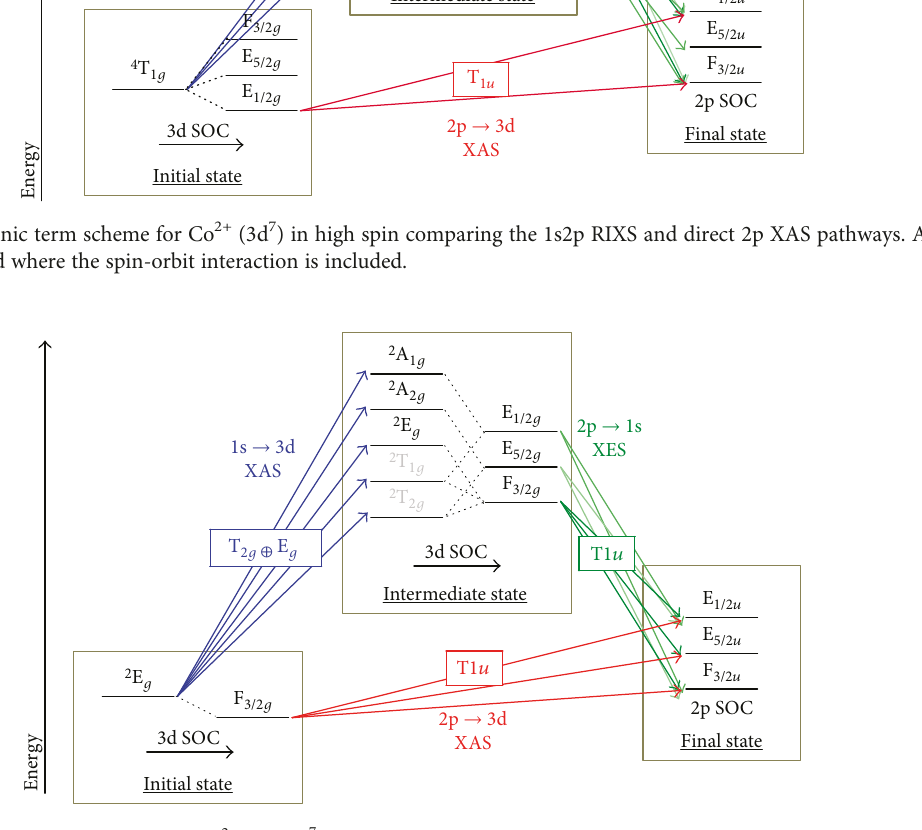
Figure 52: Multielectronic term scheme for a Co 2+ ion ( 3d 7 ) in low spin comparing the 1s2p RIXS and direct 2p XAS pathways. Where SOC is included, the spin multiplicity is